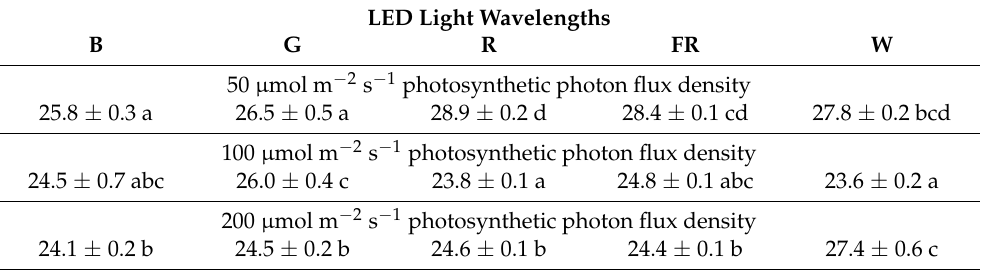
Table 4. The average recovery of C. acutatum mycelium after illumination by various LED light photosynthetic photon flux densities, mm.